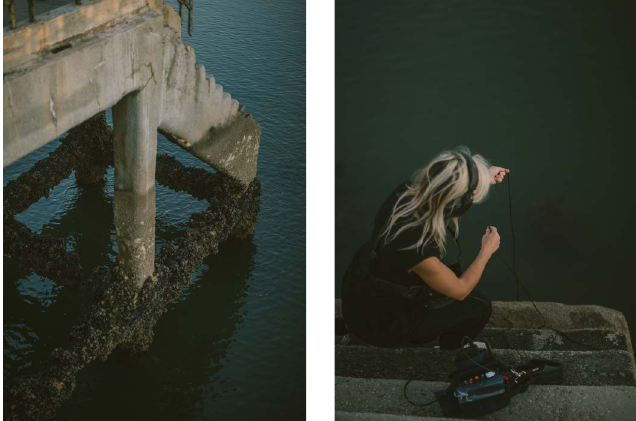
Figures 8 and 9: Ilha de Faro. Ria Formosa. Second